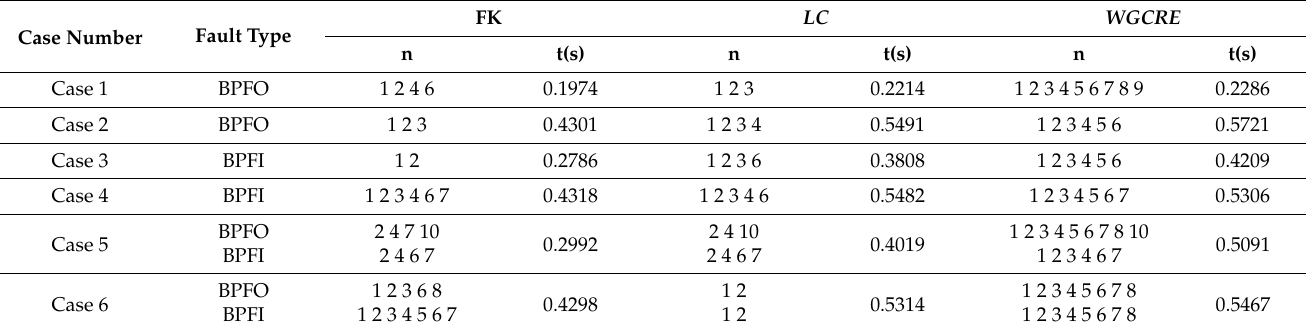
Table 3. Captured serial numbers n of BPFs with computation cost t statistics